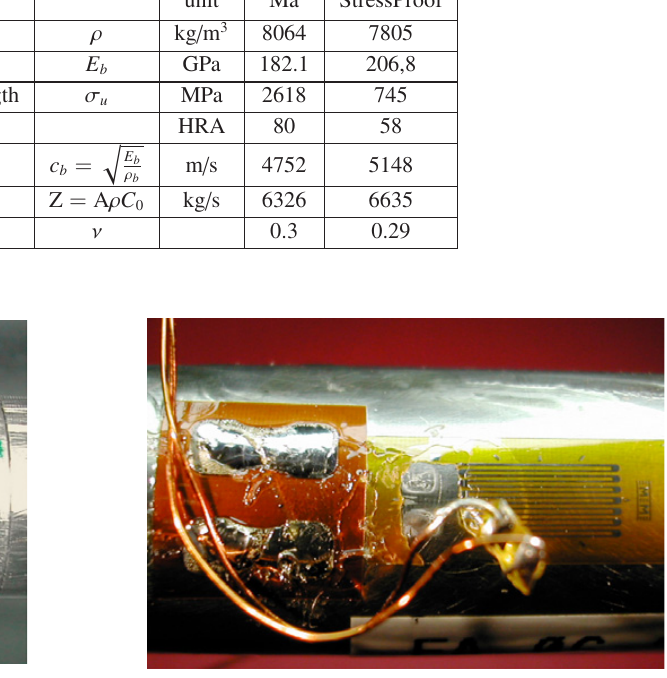
Fig. 1. Standard installation of strain gage before investigation.